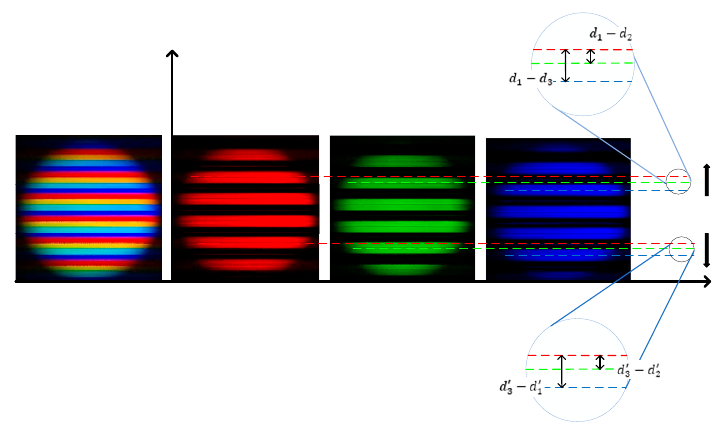
Figure 12. Calculate the skewing.